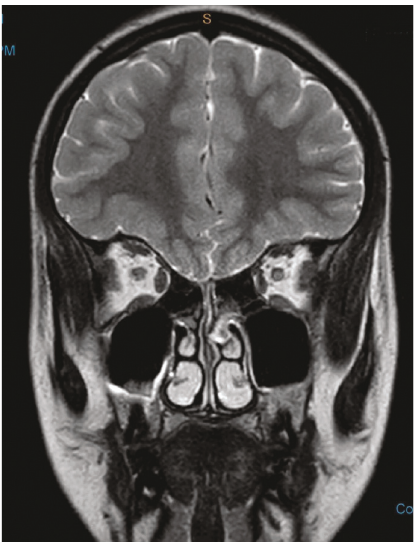
Figure 4: Coronal view showing the absent olfactory tract.